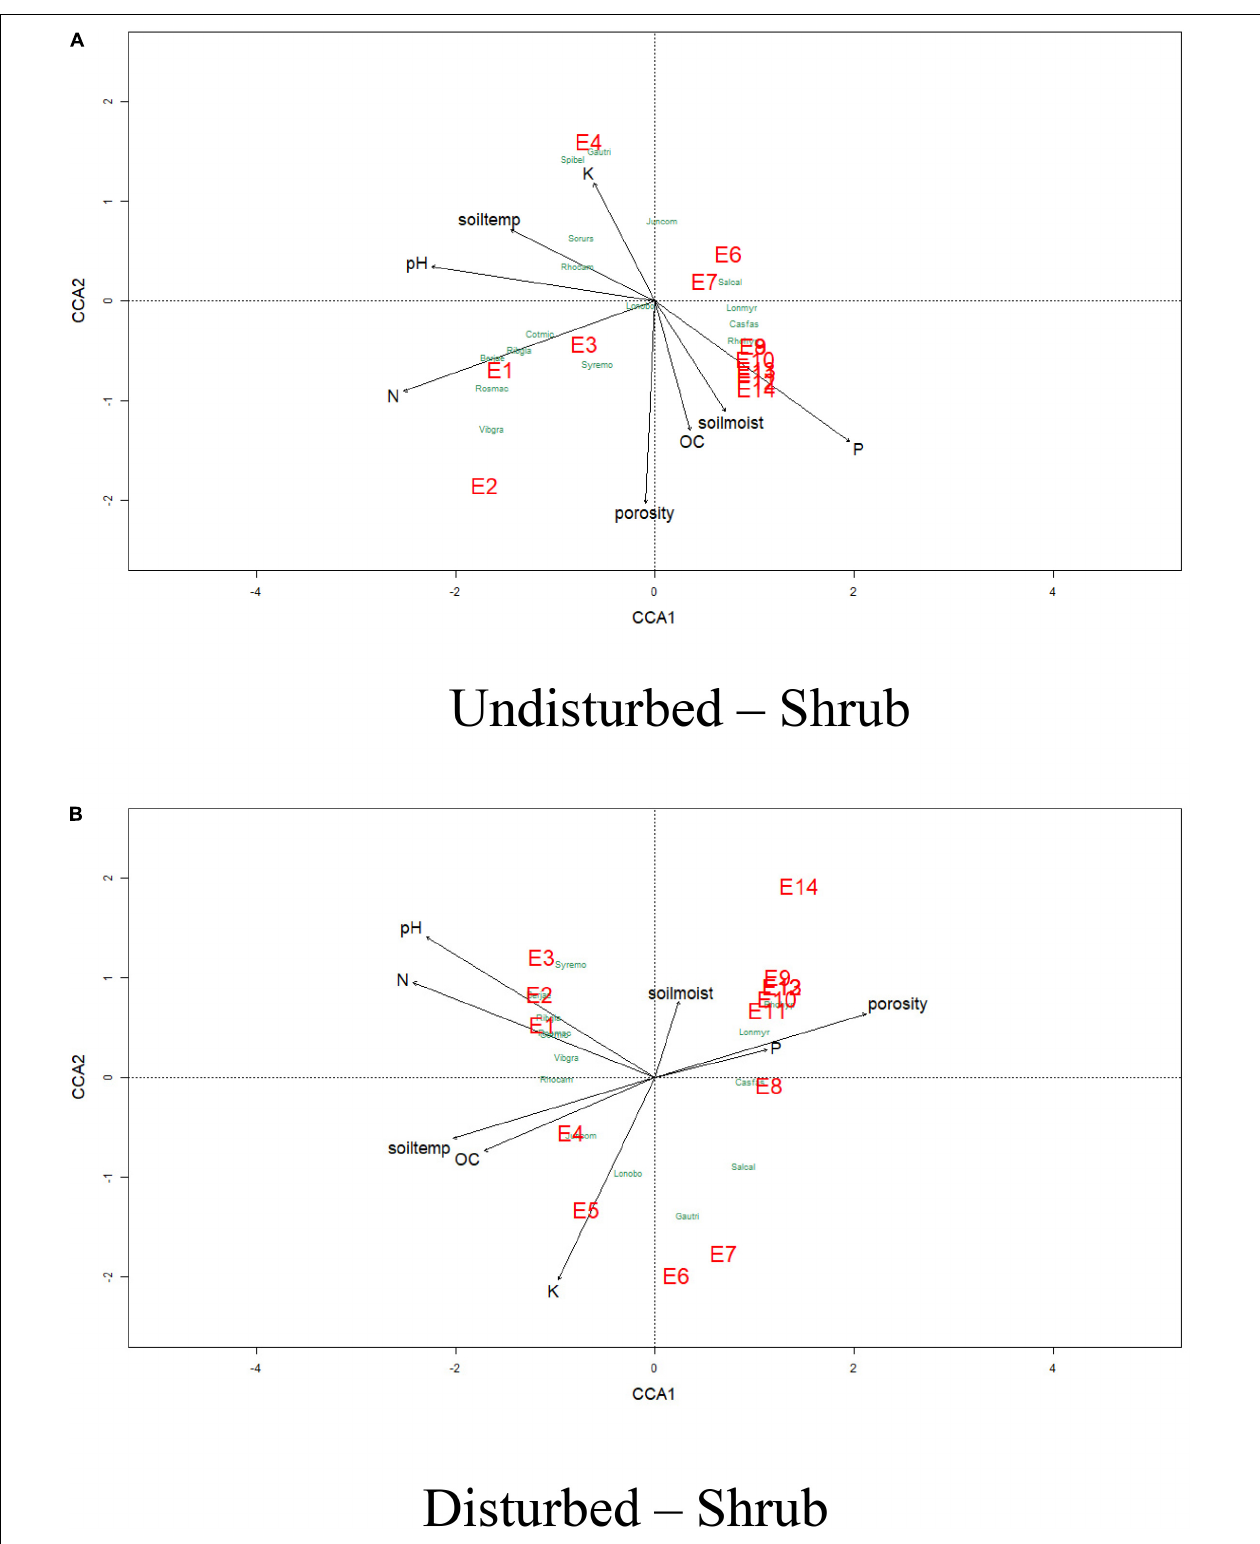
FIGURE 10 | Canonical correspondence analysis of vegetation abundance and elevation (represented by E) overlaid to soil parameters at a p.max = 0.25 for undisturbed and disturbed quadrates of shrubs in VoFNP.